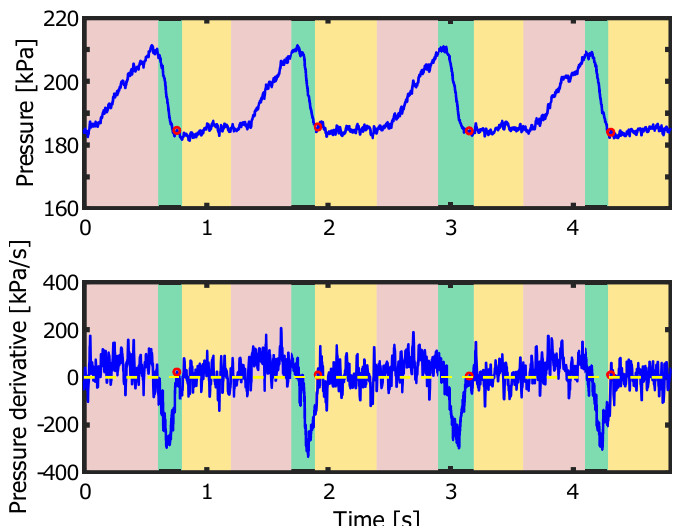
Figure 12. Sample data of the pressure and the pressure derivative for checking Equation (8). The horizontal axis shows time (s), and walking phases are distinguished by color areas. Red areas represent the stance phase, green areas represent the pre-swing phase, and yellow areas represent the swing phase. The ( upper ) figure shows the pressure in the RCB PARM. The ( lower ) figure shows the pressure derivative in the RCB PARM, and blue solid lines and yellow dashed lines are calculated value and the threshold 0 kPa/s. Red circle markers are assist timing k a